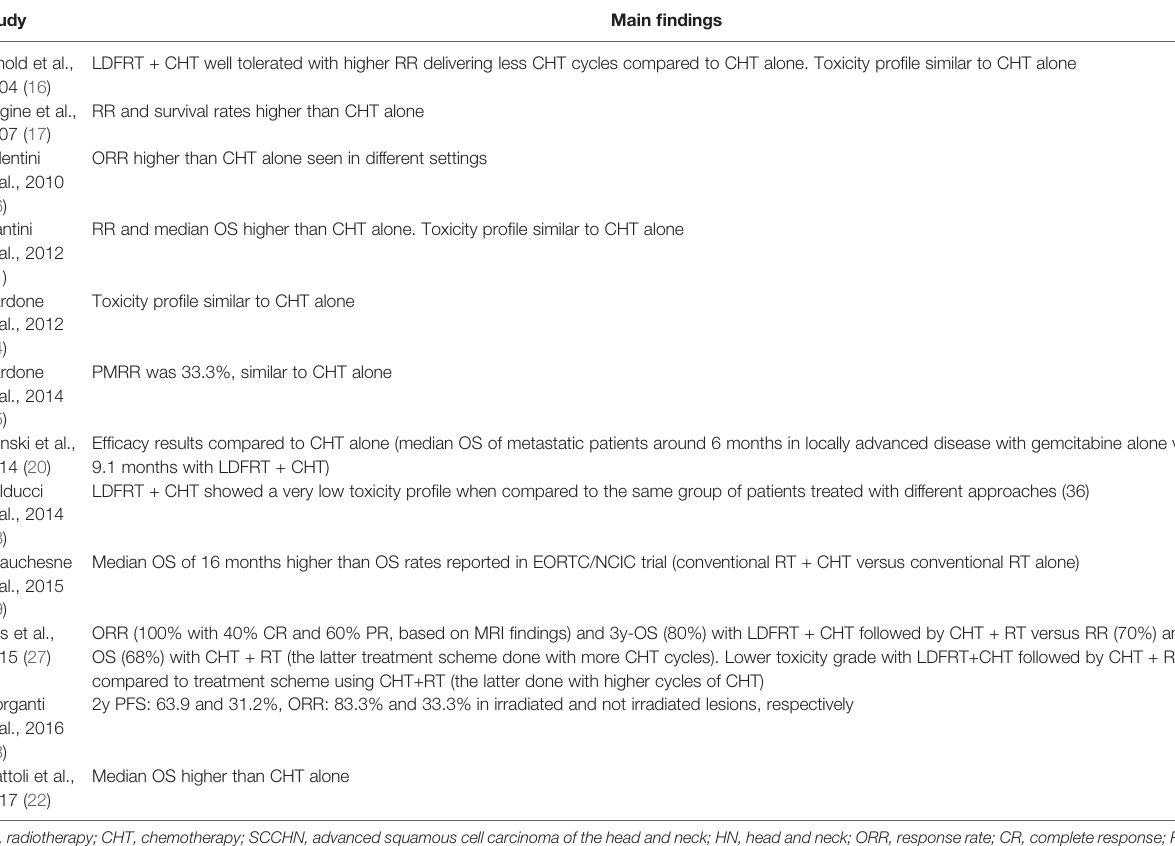
TABLE 4 | Comparisons with chemotherapy